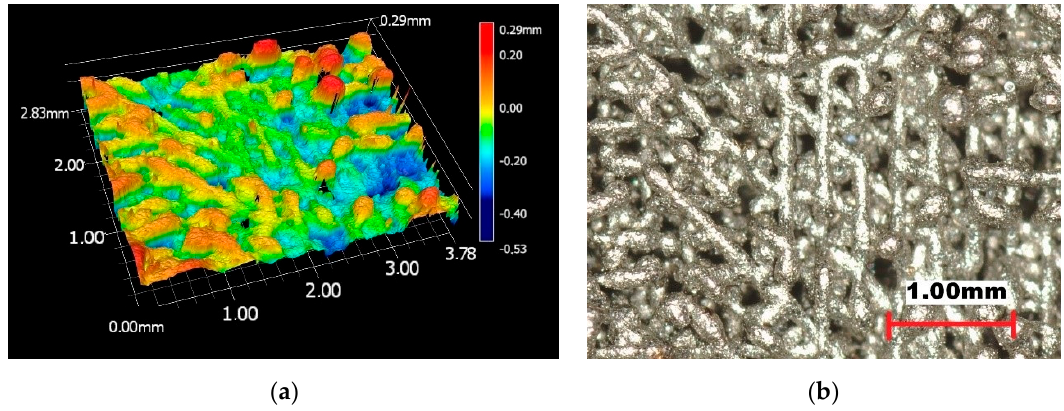
Figure 8. Surface of selective laser melting (SLM)-built metal substrate. ( a ): 3D view. ( b ): Top view.